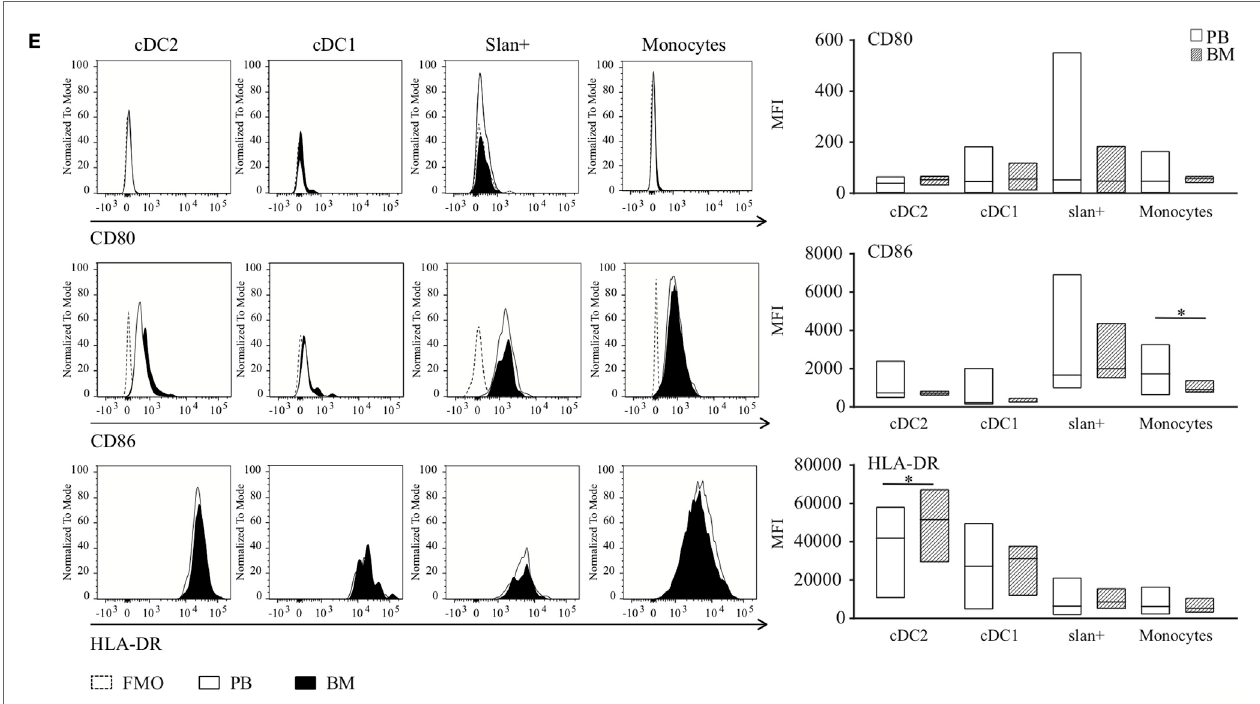
FigUre 1 | Dendritic cell (DC) and monocyte enumeration and baseline expression levels of (co-) stimulatory molecules in BM and PB. (a) Gating strategy for DC and monocyte subsets. CD45 + MNCs were gated after debris and doublet exclusion. Thereafter, cell subsets were identified based on the expression of CD1c (cDC2), CD141 (cDC1), or M-DC8 (slan + non-classical monocytes). Classical monocytes were selected based on their high CD14 expression. (B) Frequencies of slan + cells, monocytes, and the myeloid DC subsets cDC2 and cDC1 in human BM as compared to human PB. Percentages were calculated from the total CD45 + mononuclear cell fraction. Individual results and median percentages are shown for 17–21 (PB) and 13–20 (BM) healthy donors. Monocytes formed the main population in both compartments (PB, 16.0% and BM, 12.5%), followed by cDC2 (PB, 0.53% and BM, 0.60%) and slan + non-classical monocytes (PB, 0.92% and BM, 0.39%). In BM as well as in PB, cDC1s were only present in low percentages (PB, 0.043% and BM, 0.081%). (c) Paired frequencies of PB and BM subsets, derived from one donor. A Wilcoxon matched-pairs signed rank test was performed to compare the PB and BM compartment ( n = 7 donors, cDC2, and monocytes: no significant differences, cDC1 p = 0.03 and slan + p = 0.02). (D) Baseline expression levels of HLA-DR ( n = 7) and the co-stimulatory molecules CD80 ( n = 6) and CD86 ( n = 7) on BM-derived cell subsets. Individual experiments and median values are shown. (e) A comparison of baseline expression levels of three different activation markers between cell subsets from the PB ( n = 14–23) and BM ( n = 6–7) compartment. Histograms of the different markers of a representative donor and bar graphs of repeated experiments are shown. Median MFI values of individual stainings of the different cell subsets are compared between the two compartments. For CD80 and CD86, FMO controls are shown as a dotted line. Abbreviations: BM, bone marrow; PB, peripheral blood; WBC, white blood cells; MNC, mononuclear cells; MFI, median fluorescence intensity; FMO, fluorescence minus one. * p < 0.05, ** p < 0.01, *** p < 0.001, and **** p <